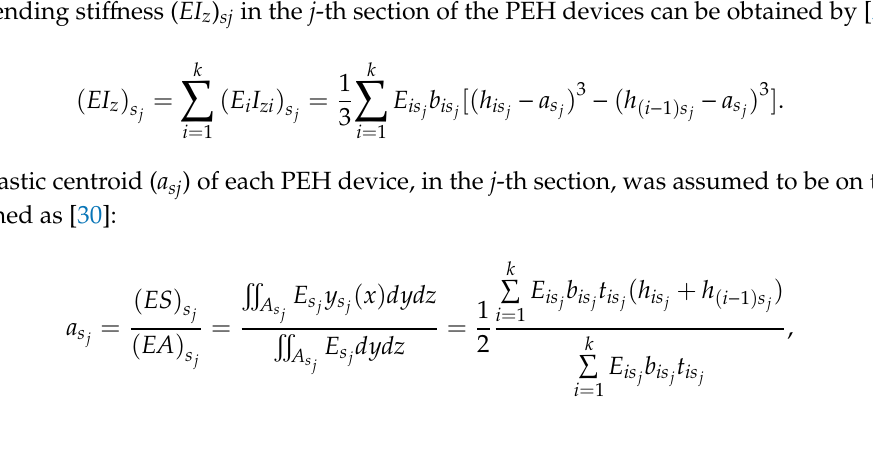
Figure 2. Schematic view of a cross-section of the i -th layer on the j -th section of the MEMS-based PEH devices.